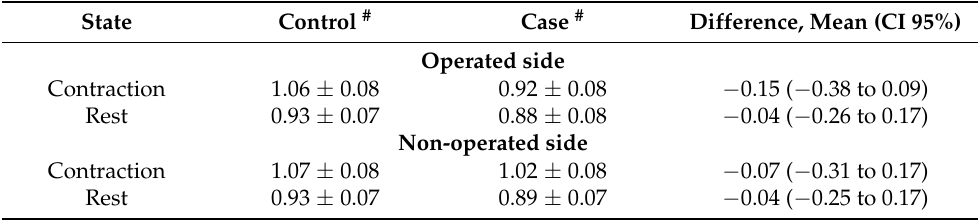
Table 4. Adjusted differences in contraction and relaxation